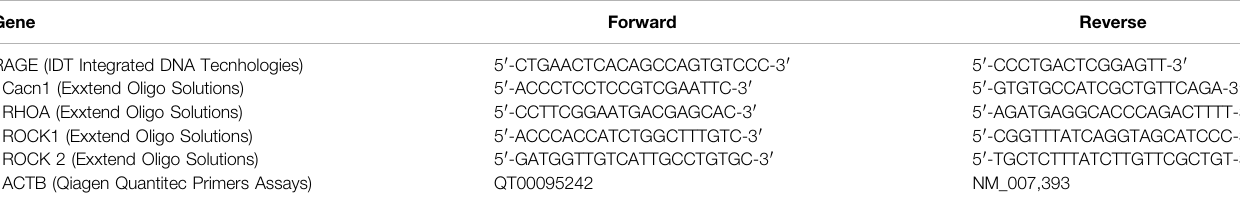
TABLE 1 | Primer sequences used for real-time PCR ampli fi